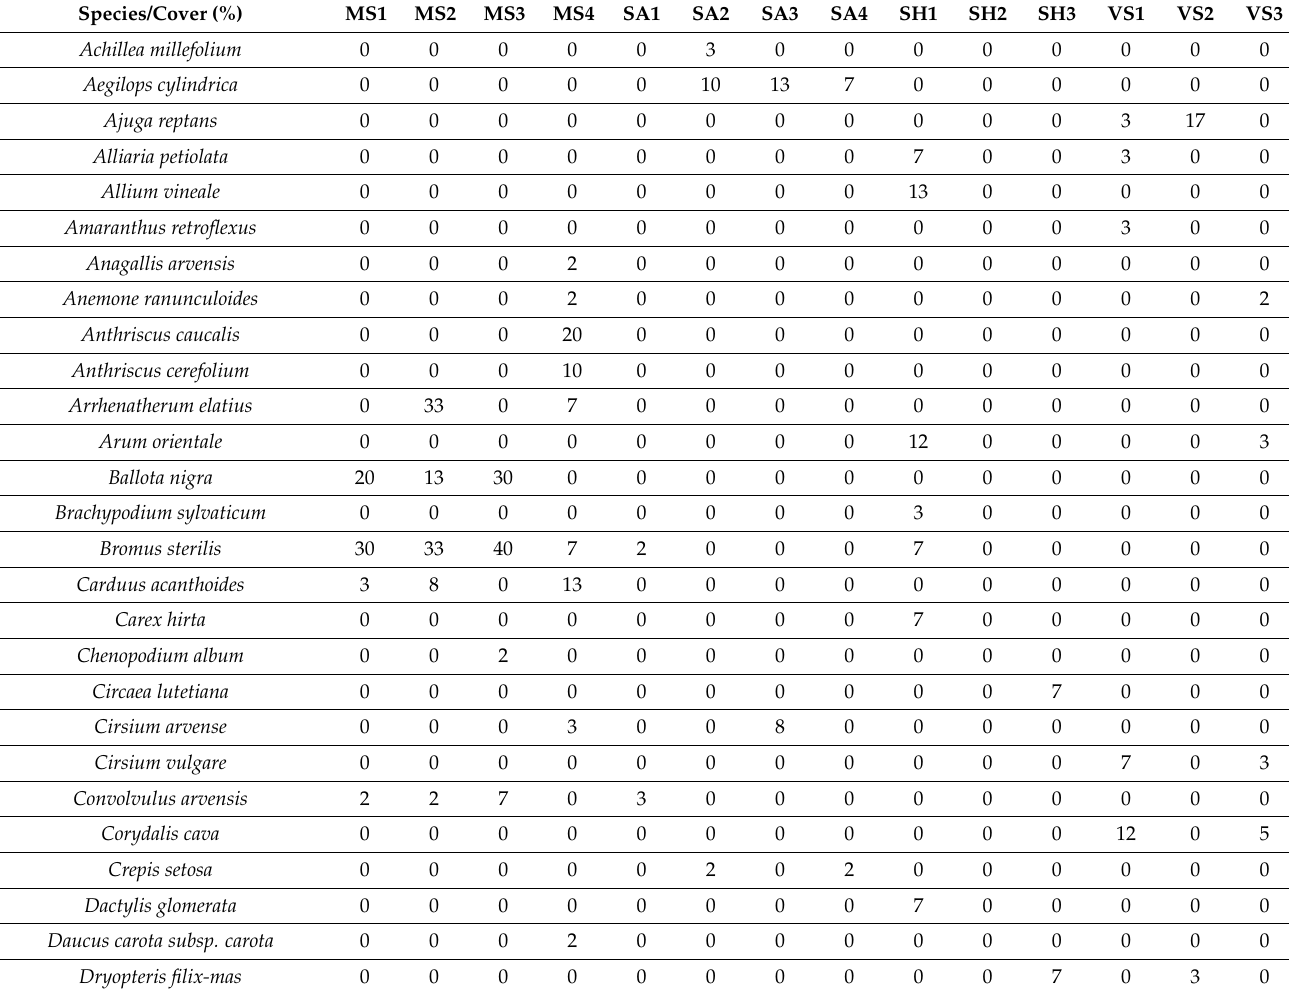
Table A3. Herbaceous species list and cover